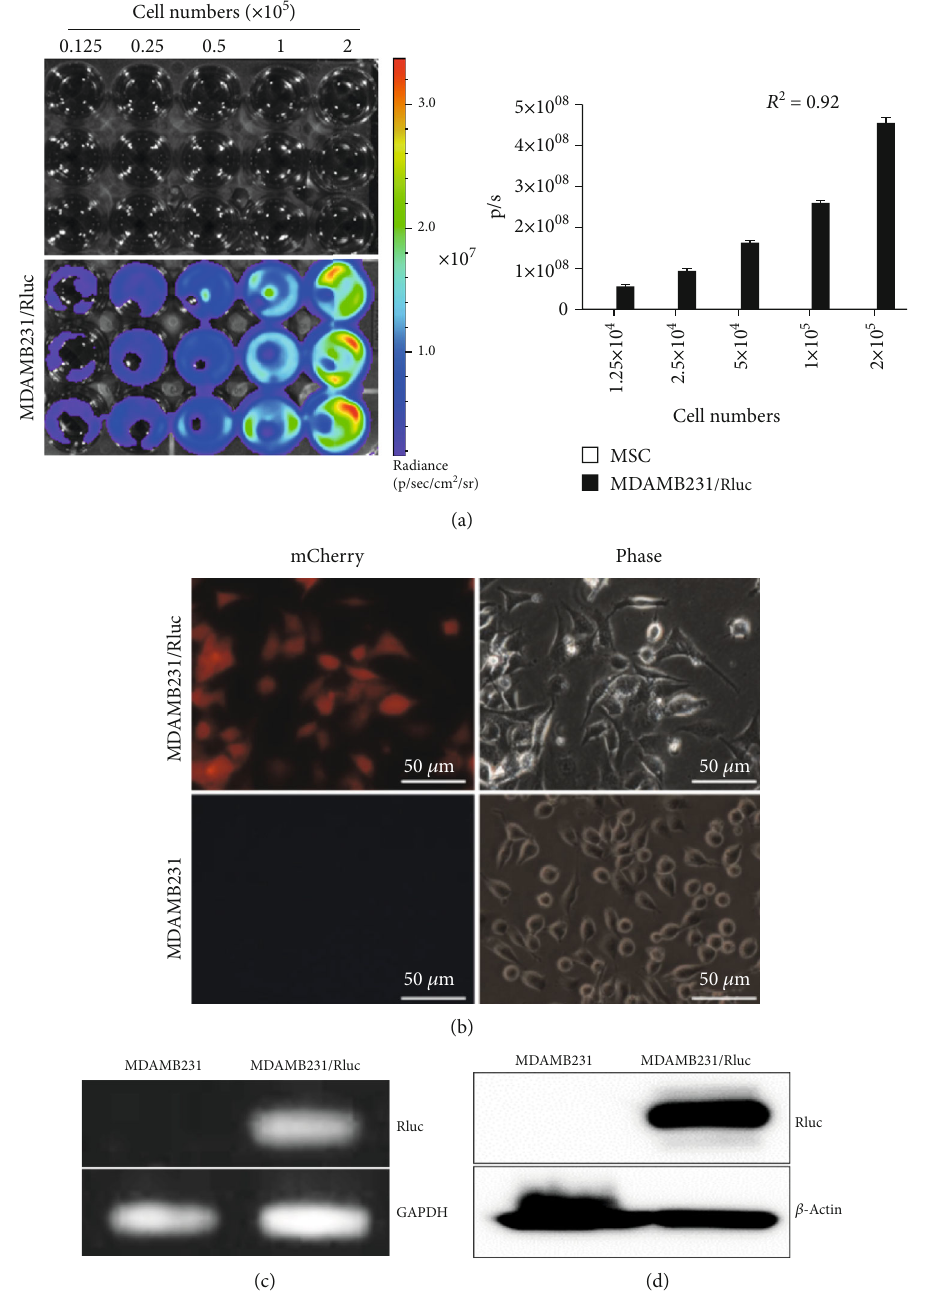
Figure 3: Characterization of MDAMB231/Rluc. (a) Rluc activity assessed by bioluminescent imaging (BLI) and quantitative analysis of MDAMB231/Rluc at di ff erent concentrations. (b) Transduced MDAMB231/Rluc cells were strongly positive for mCherry by fl uorescence microscopy. (c) Rluc mRNA expression by RT-PCR. (d) Rluc protein expression by Western